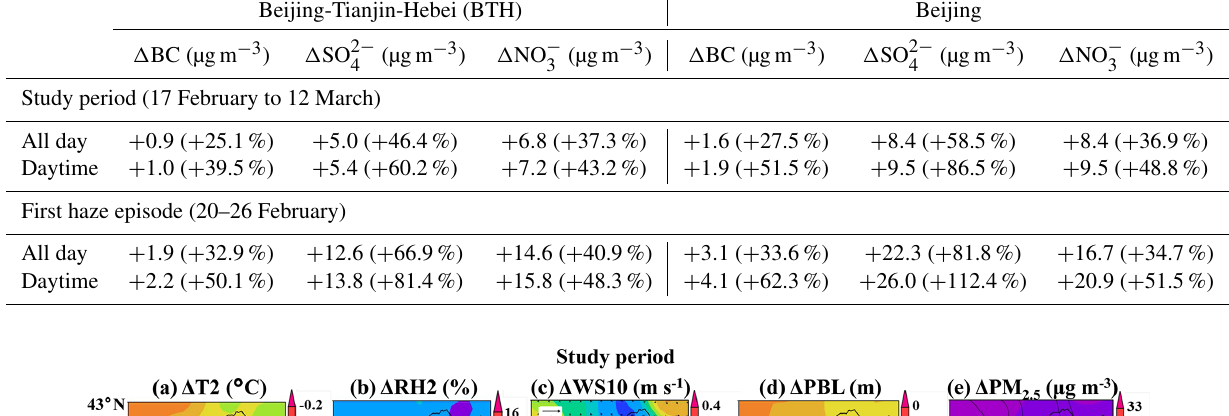
), and nitrate (NO − ) averaged over 4 3